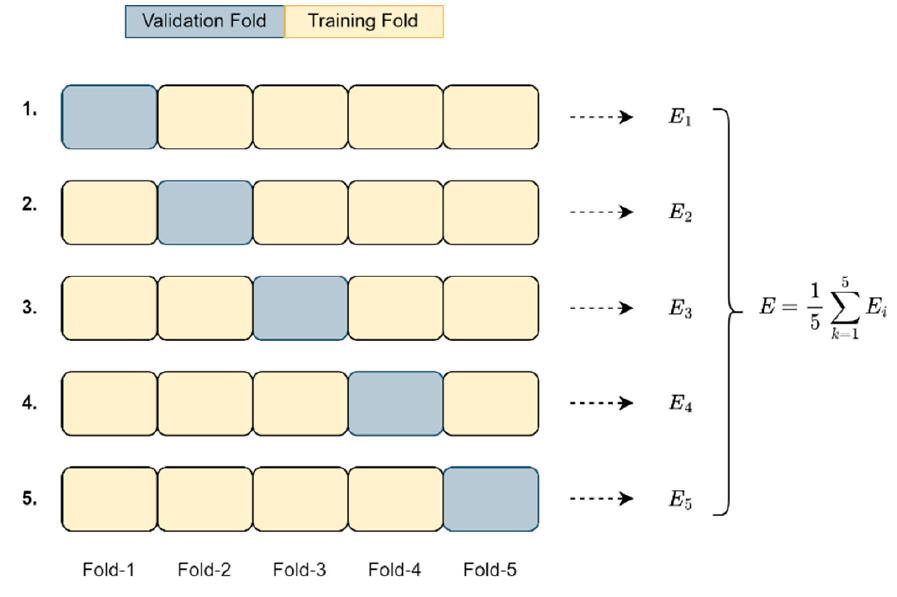
Figure 6. 5 ‐ Fold Cross ‐ Validation.